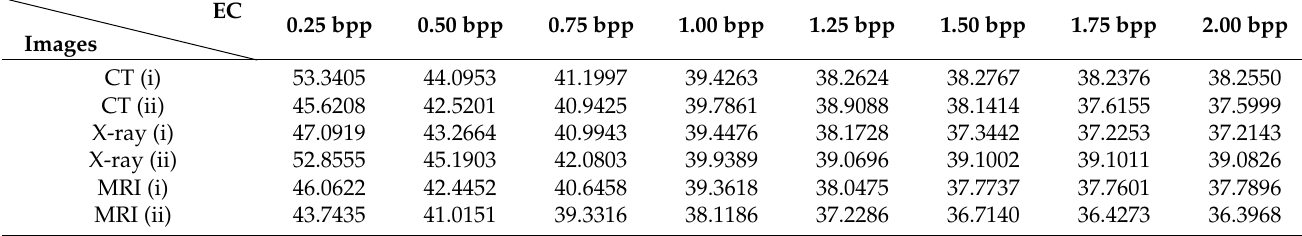
Table 2. PSNR for different EC values.